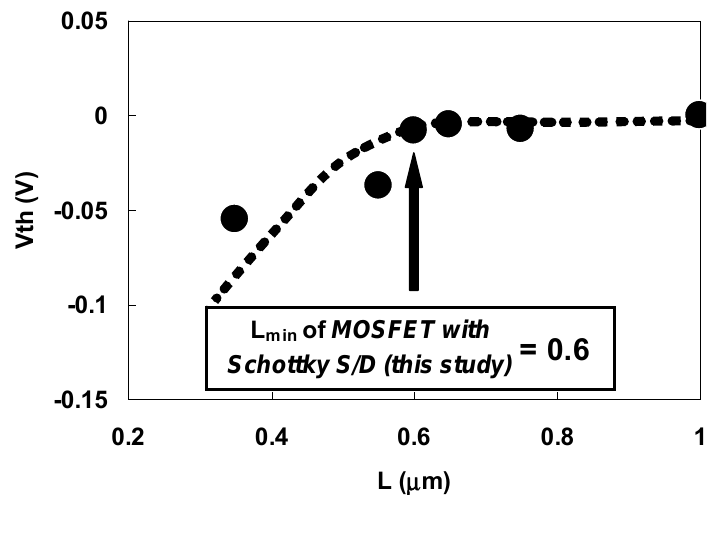
Figure 46. Id-Vg characteristics for gate lengths ranging from 0.35 μ m to 1.0 μ m for n-MOSFETs annealed for 1 min at 450 °C after sulfur